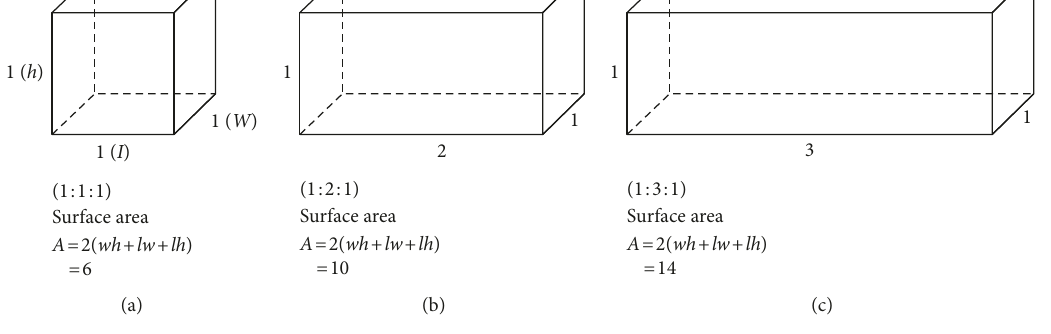
Figure 2: Surface-to-volume ratio.